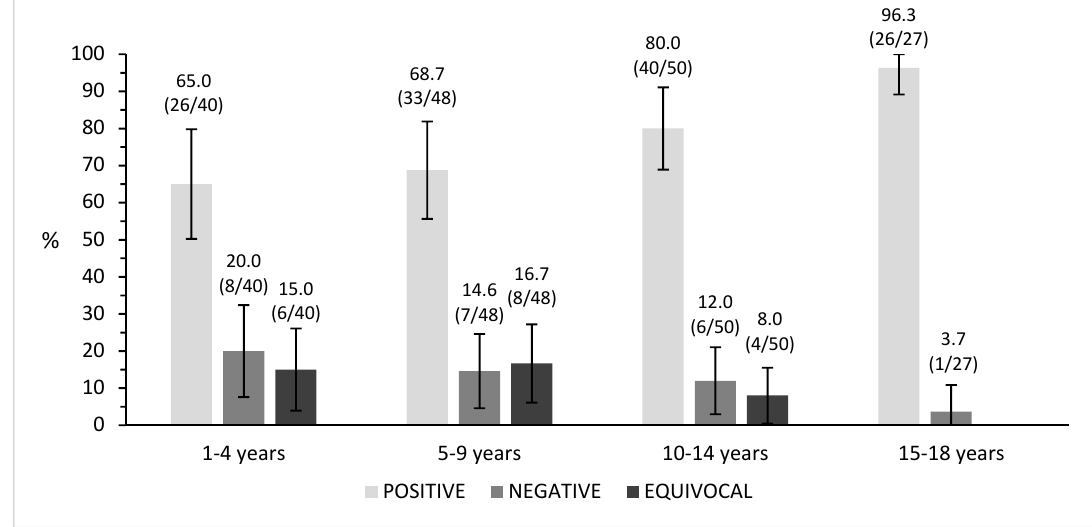
Figure 1. Percentage of immunity distribution in the age groups. Percentages and ratios ( n / N ) are shown above each column.